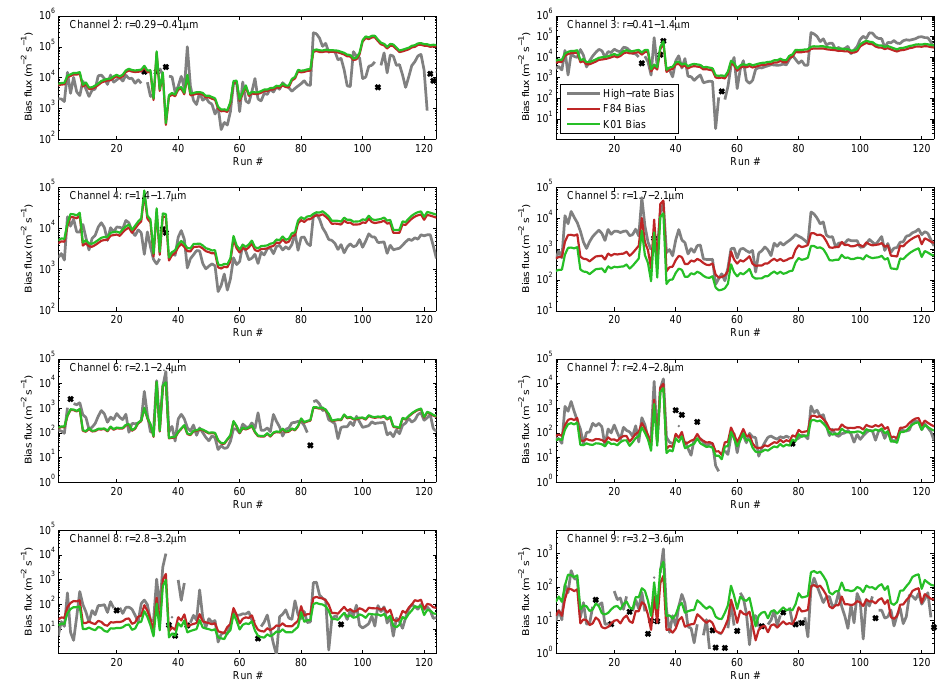
Fig. 8. Flux bias due to hygroscopicity, ( = 1v d N | ), calculated through K01’s and F84’s methods, and the difference in the high-rate RH number flux, N 0 w 0 , between raw and RH-corrected (to run mean) spectra. Black crosses indicate a negative high-rate flux bias. CLASP channels 2–9 are